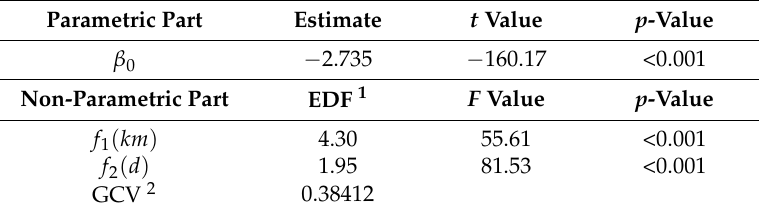
Table 4. Results for model